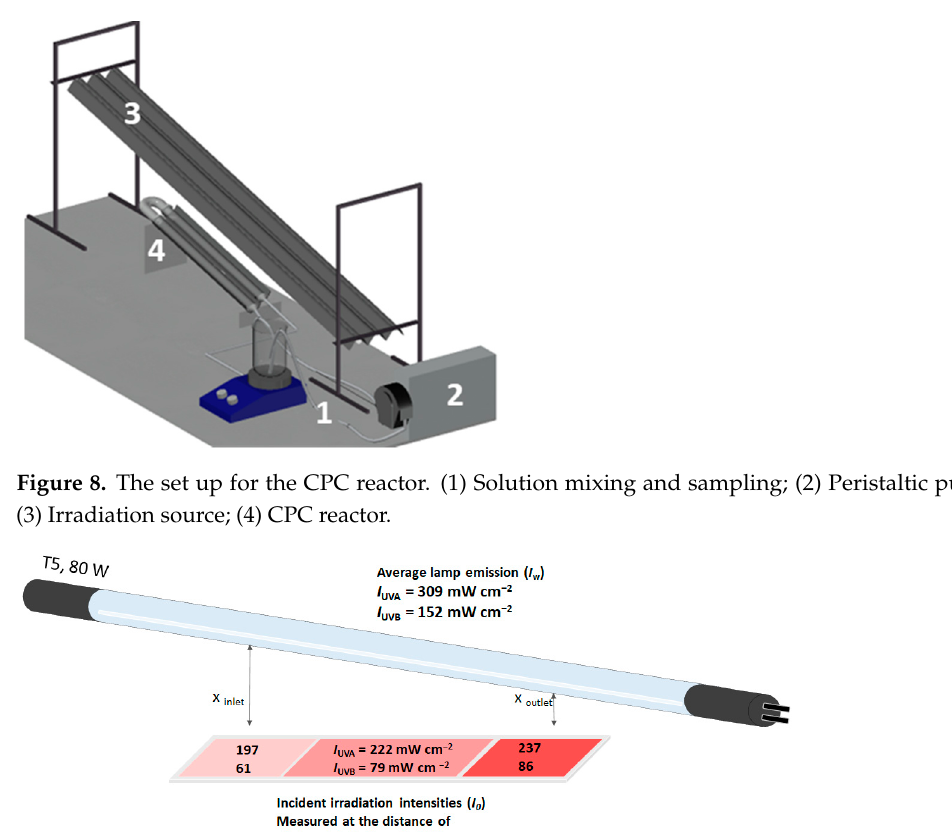
12 of 18 Figure 7. The image of photocatalysts: ( a ) TiO 2 photocatalytic film on glass fiber mesh, ( b ) TiO 2 /CNT photocatalytic film on glass fiber mesh. Characterization was performed by using Raman spectroscopy (HORIBA Jobin Yvone T64000 spectrometer, Bensheim, Germany) with a 532.5 nm, solid-state laser exci- tation); the scanning electron microscopy (FEG SEM Quanta250 FEI microscope, Hills- boro, Oregon, USA) and diffuse reflectance spectroscopy (DRS, Perkin-Elmer Lambda 35, Waltham, MA, USA). Additional information were described in more details in our pre- vious paper [52]. 3.3. Reaction Set Up